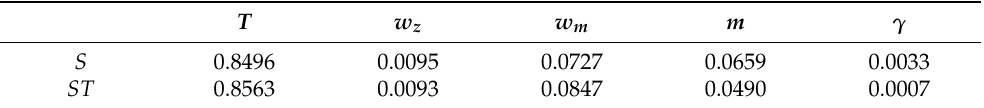
Figure 9. ( a ) First-order Sobol index pie charts and ( b ) total Sobol index pie charts of the five parame- ters for the infrasound propagation maximum height. The five uncertain atmospheric environmental parameters are independently and uniformly distributed. The number of Sobol samples N is 5000. Table 3. First Sobol index S and total Sobol index ST of each atmospheric parameter for the infrasound propagation maximum